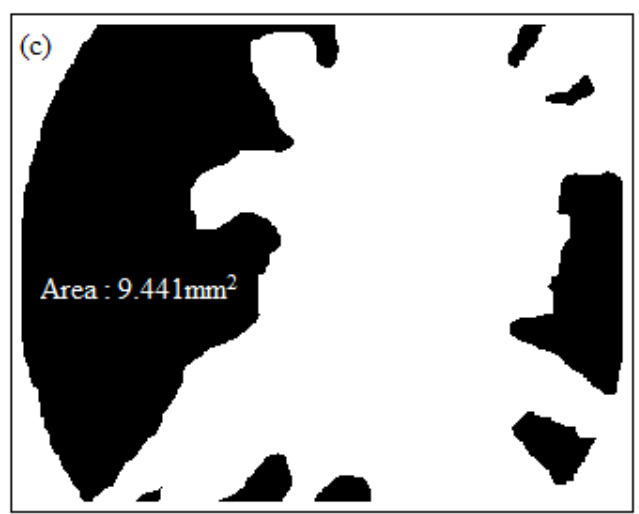
Figure 2. Tegument or shell is the outer part of the seed that acts against external factors. SEM micrographs of ( a ) açaí seed obtained by compression; ( b ) detachment of the açaí tegument by color (red color); and ( c ) measurement of the tegument area.